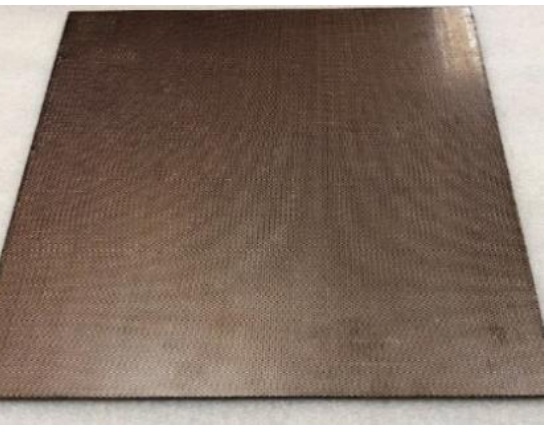
Figure 4. Test panel with ECF (L_ECF). Dimensions: 300 mm × 300 mm. The test sequence (D component and B/C components) for the panels is described in Tables 4 and 5, respectively. Table 4. T02, 2A–D Component test sequence.